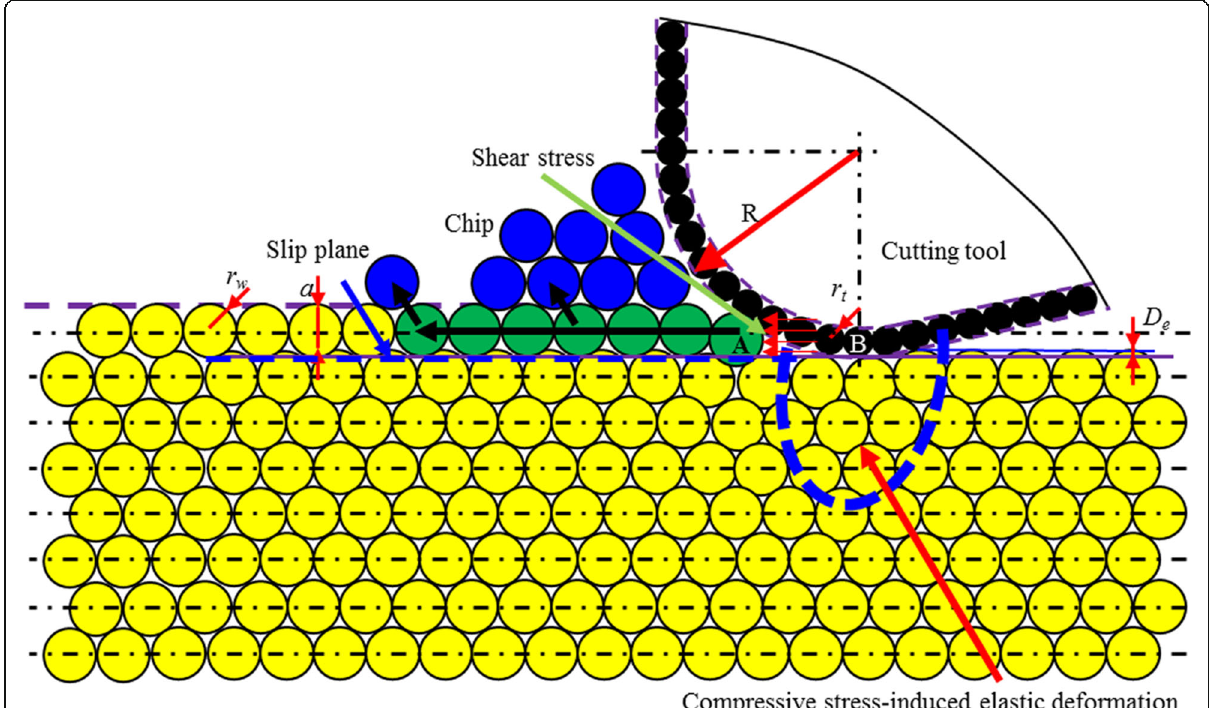
Fig. 17 Schematic illustration of cutting-based single atomic layer removal at a/r w larger than C 2 and a/R larger than T